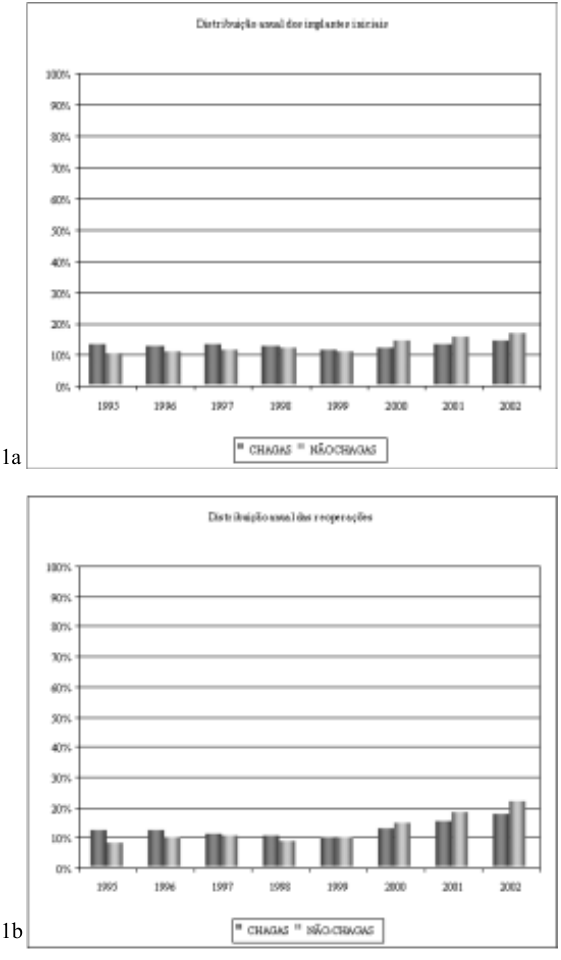
Fig. 1 - Distribuição anual dos implantes iniciais (1a) e reoperações (1b) A distribuição anual dos casos de reoperação também diferiu nos dois grupos de pacientes, embora tenha havido crescimento expressivo do número de reoperações em ambas as populações. No grupo Chagas o crescimento no